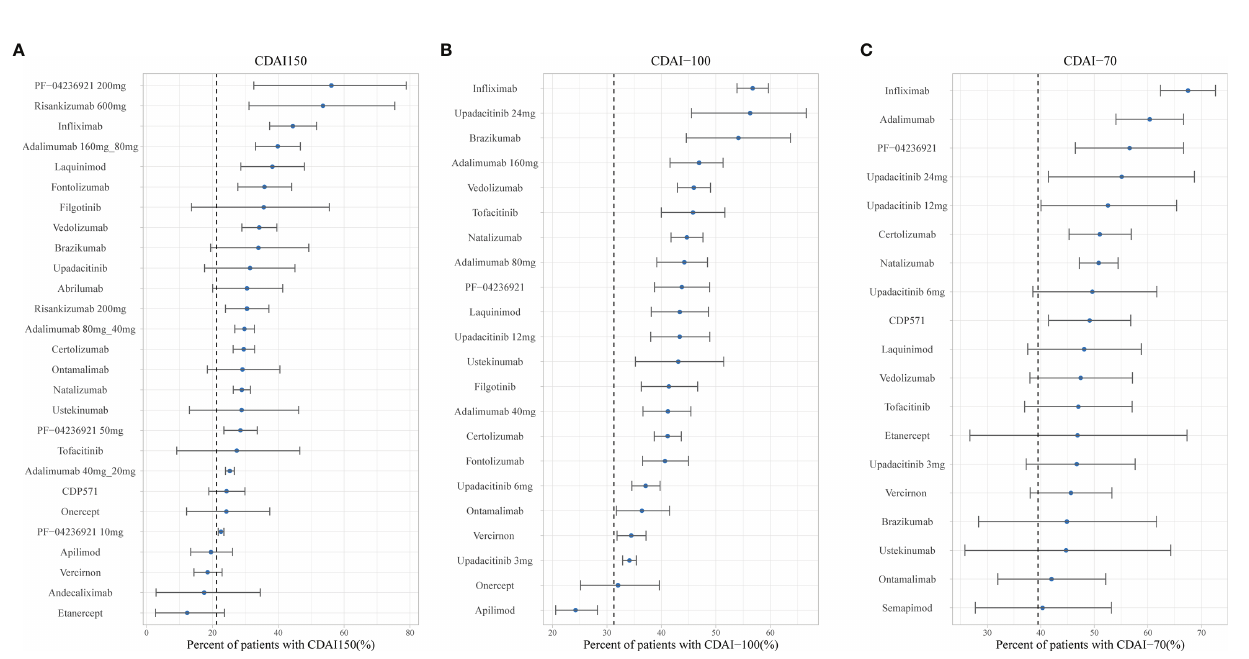
FIGURE 4 | Ranking of the treatments by predicted placebo-corrected median percent of patients with (A) CDAI150, (B) CDAI-100, and (C) CDAI-70 at week 12 (from high to low). Point estimates and 95% CIs were predicted from a model simulation of N = 10,000. Dashed lines represent simulated placebo ef fi cacy. For treatments with multiple dosage regimens, only regimens with different ef fi cacy at week 12 were listed separately. CDAI, Crohn ’ s Disease Activity Index; CDAI150, an absolute CDAI score of less than 150; CDAI-100, reduction of at least 100 points in the CDAI score; CDAI-70, reduction of at least 70 points in the CDAI score; bid, twice